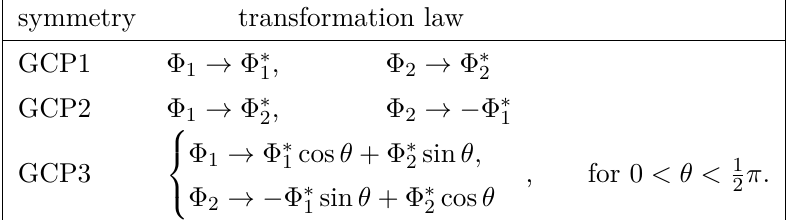
Table 2. Classification of 2HDM scalar potential generalized CP (GCP) symmetries in a generic Φ 1 – Φ 2 basis [22, 43–46]. Note that a GCP 3 symmetry with any value of θ that lies between 0 and 1 π yields the same constrained 2HDM scalar potential. The corresponding constraints on the 2 2HDM scalar potential parameters are shown in table 3.